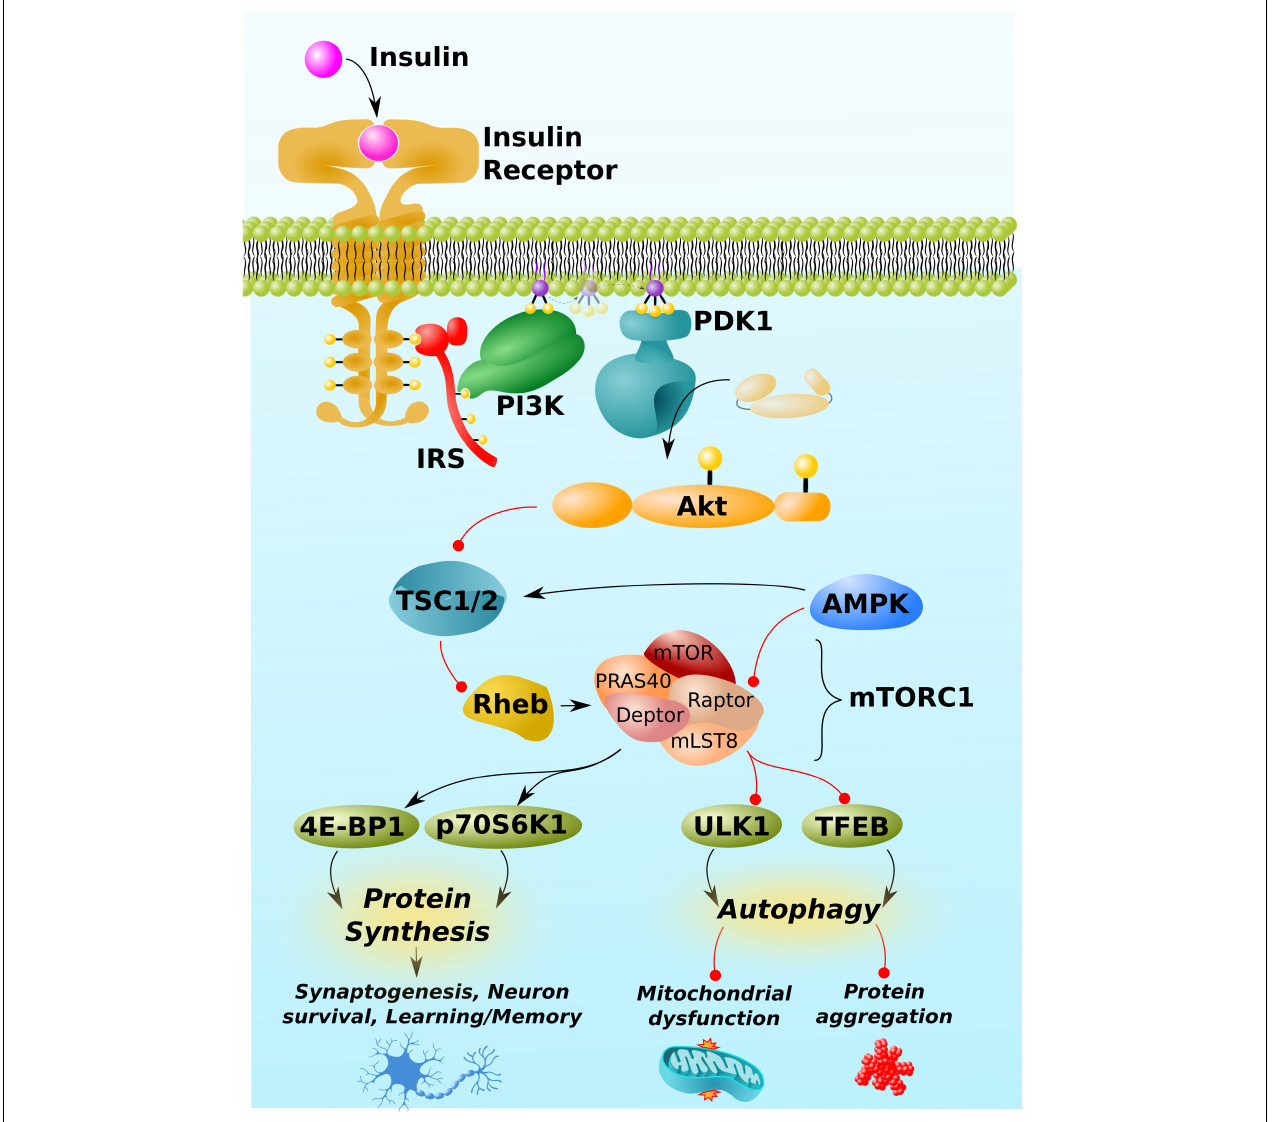
FIGURE 1 | mTORC1 pathway and regulation. mTORC1 is activated by insulin. Insulin/Akt signaling inhibits TSC1/2, thereby permitting the activation of the GTP-binding protein, Rheb. Rheb is the proximal activator of mTORC1. AMPK inhibits mTORC1 activity through indirect and direct mechanisms, phosphorylating TSC1/2 and the Raptor regulatory component of mTORC1. (Other trophic factors and pathways beyond insulin/Akt and AMPK, not shown for simplicity, also regulate mTORC1). mTORC1 downstream targets include proteins involved the mRNA translation, 4E-BP1 and p70S6K1, and those involved in autophagy, such as the initiator of autophagy, ULK1, and the master regulator of lysosomal biogenesis, TFEB. By regulating the activity of these and other proteins, mTORC1 promotes protein synthesis, which is required for synaptogenesis, learning, and memory, but can also impair autophagy, leading to mitochondrial dysfunction and neurotoxic protein aggregation (A β , phospho-tau, α -synuclein, etc.). Black arrows and red lines respectively represent positive and negative